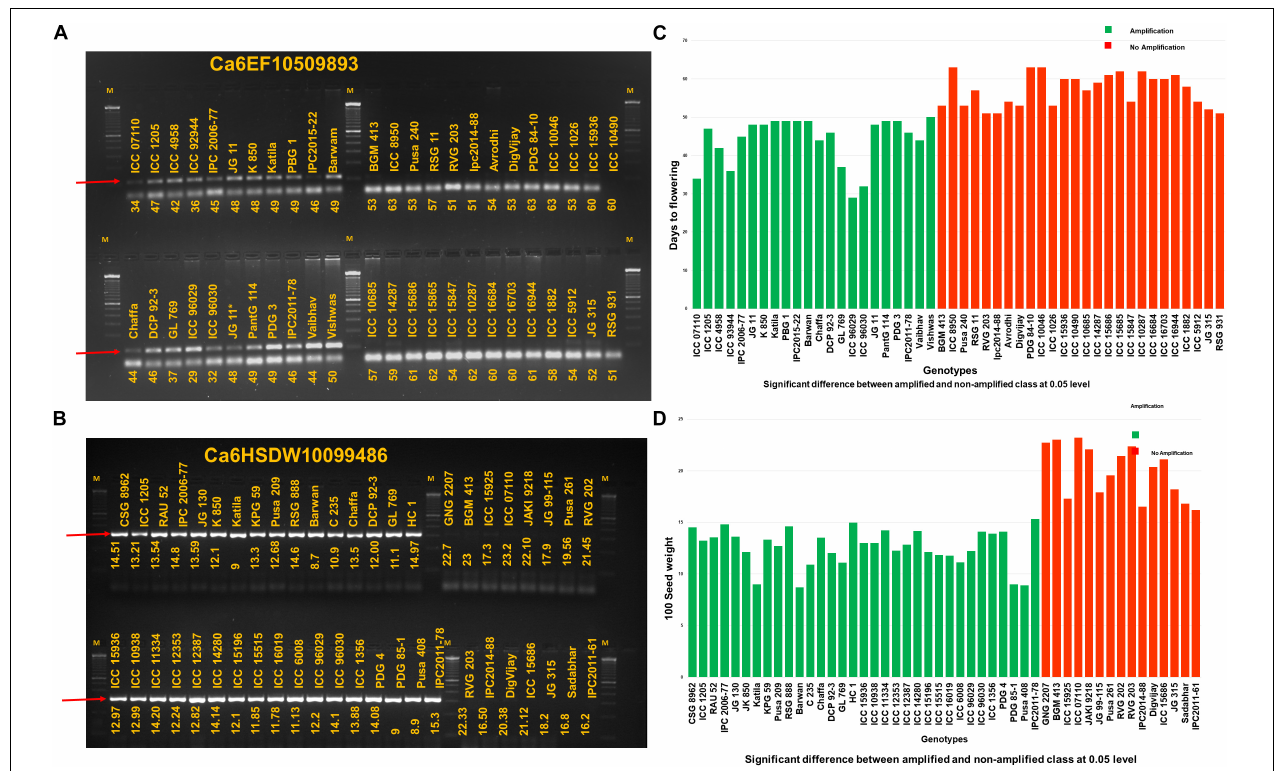
FIGURE 3 | Markers developed for early flowering and seed size (A) The marker allele-specific marker Ca6EF10509893 for early flowering shows amplification in early flowering genotypes and no amplification in late flowering genotypes and (B) similarly, in the case of allele specific marker Ca6HSDW10099486 for 100-seed weight amplification can be seen and no amplification in case of genotypes with high 100-seed weight. M is the 100-bp marker. Allele-specific amplicons are indicated with the red color arrow. A clear significant difference ( p < 0.05) between the amplified and non-amplified genotypes based on their phenotypic values for Ca6EF10509893 and Ca6HSDW10099486 can be visualized in (C,D) ,